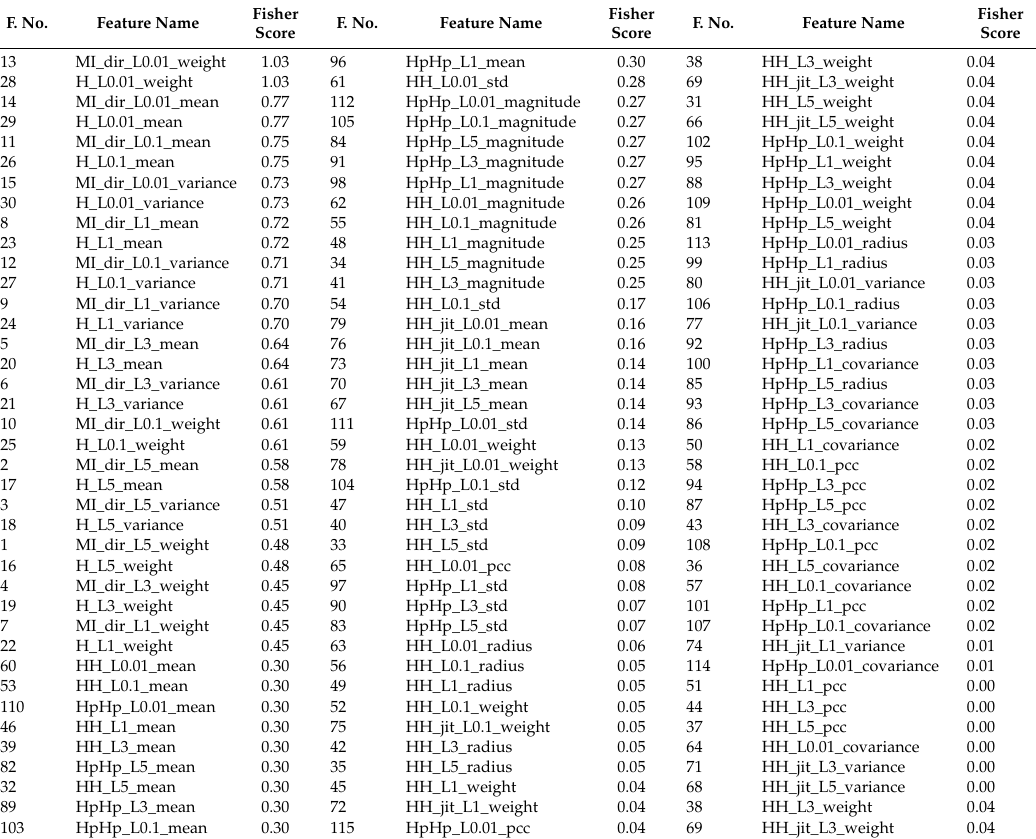
Table 2. The features with their Fisher scores.